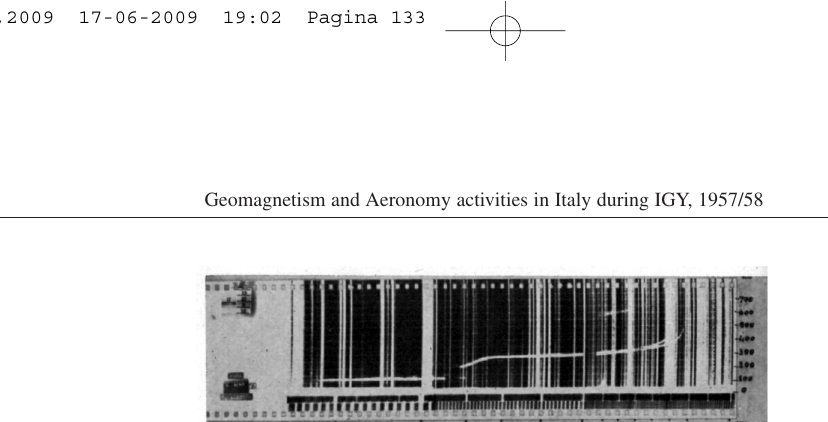
ionospheric forecasting on a global scale (ING, 1963).